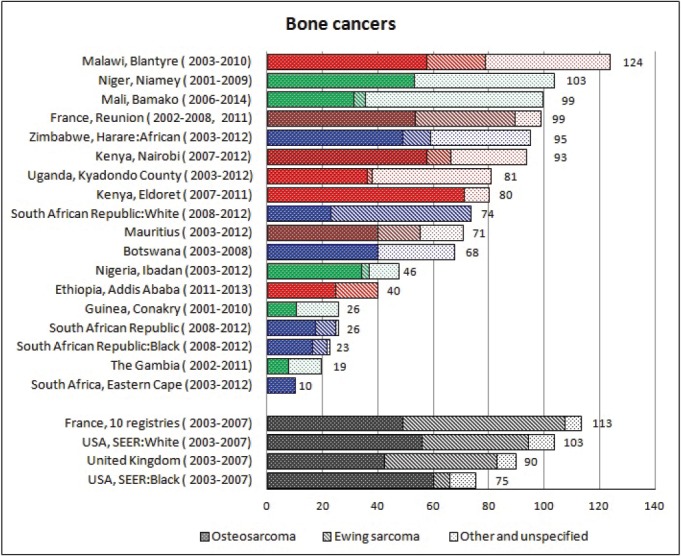
Cumulative (0–14) incidence rate—osteosarcoma, Ewing sarcoma and others.